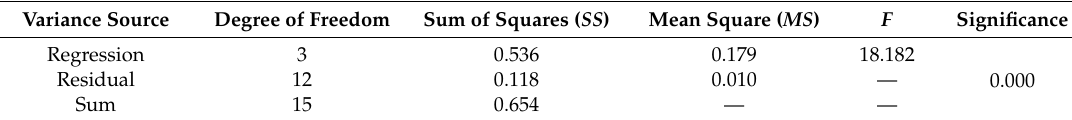
Table 10. Regression variance of F x .